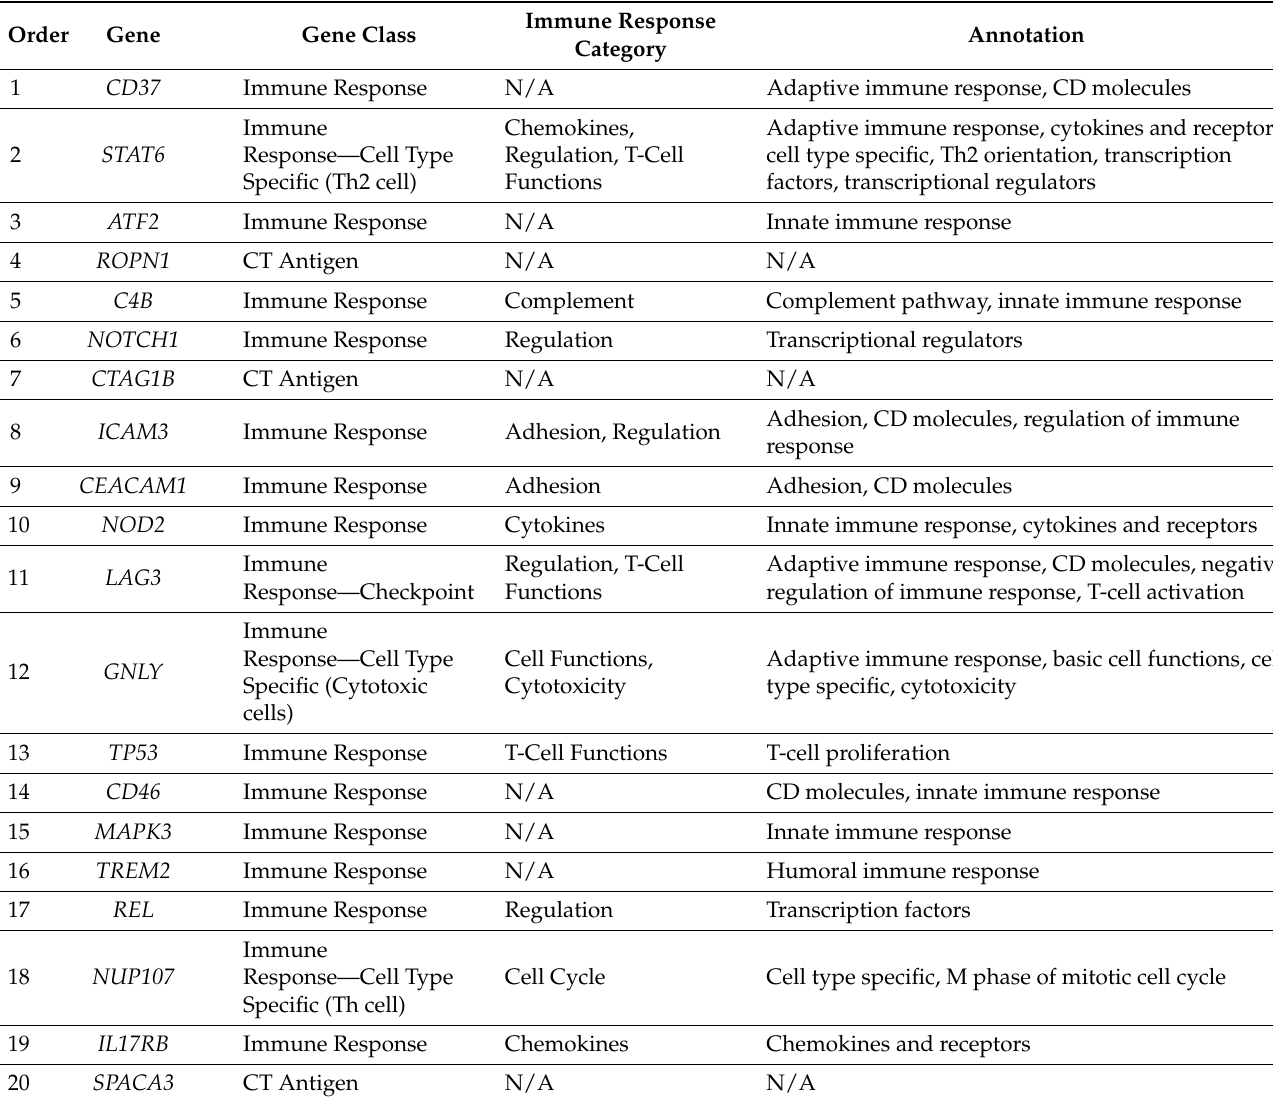
Table A4. Annotations of the molecular subtypes top